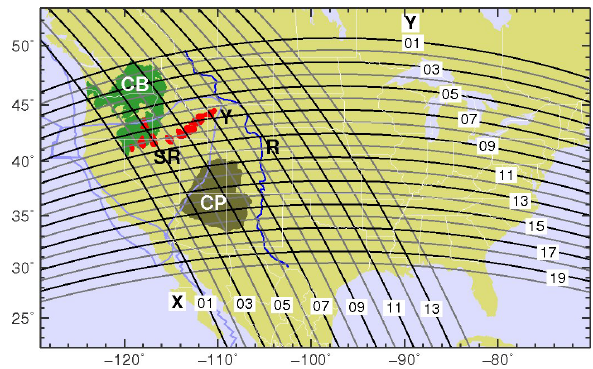
Fig. 1. Map of the seismic stations used for this study. Dense light inverted triangles: USArray stations at the beginning of 2011; sparse dark inverted triangles: permanent stations. Key: CP=Colorado Plateau, CB=Columbia basalts, R=Rocky Mountains front, Y=Yellowstone Caldera, SR=Snake River calderas.